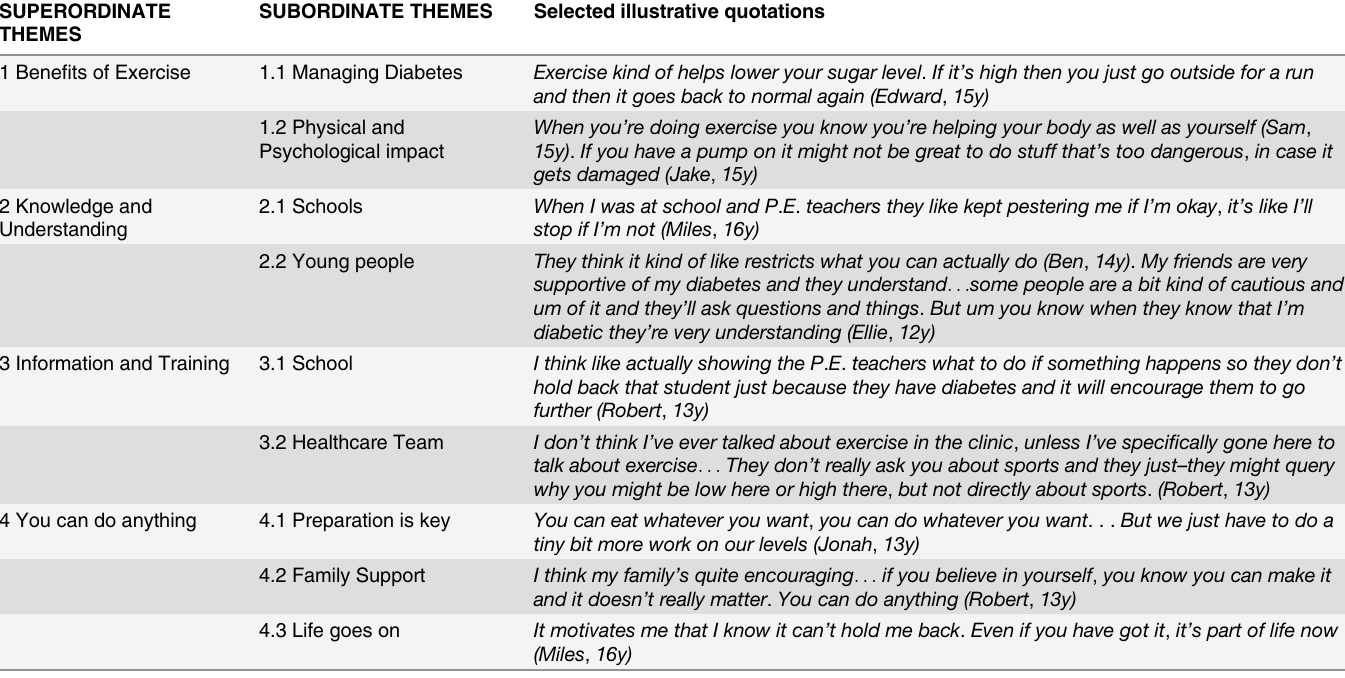
Table 2. Superordinate and subordinate themes from focus